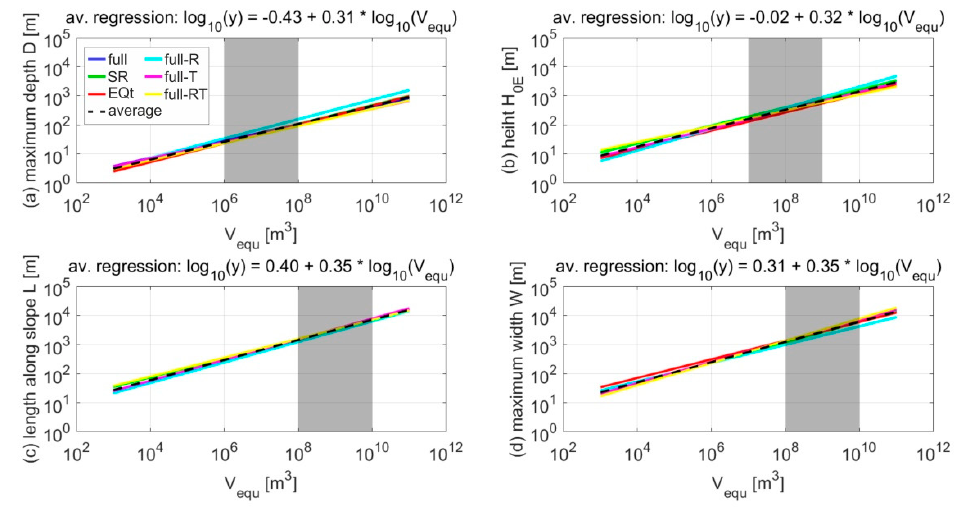
Figure 9. Comparison of regressions (D ( a ), H 0E ( b ), L ( c ), and W ( d )) of the six tested sets and the respective average regression, as shown in Table 6a. The shadings indicate the visually derived zones of maximum overlap.